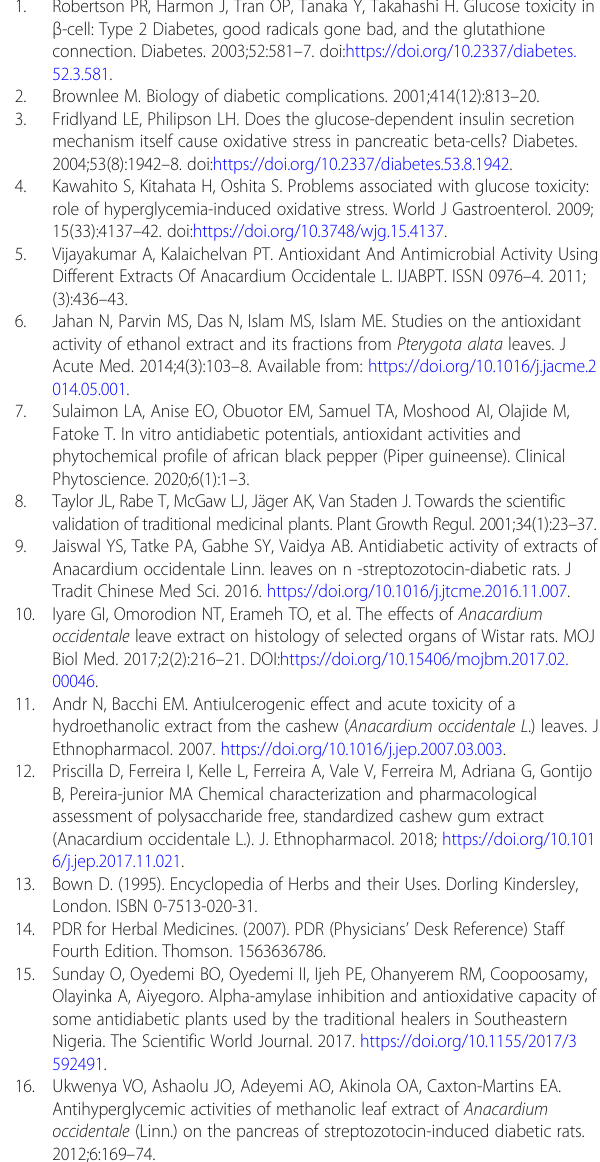
Fig. 4 Graphical Representation of Real-Time PCR Analysis of INS gene